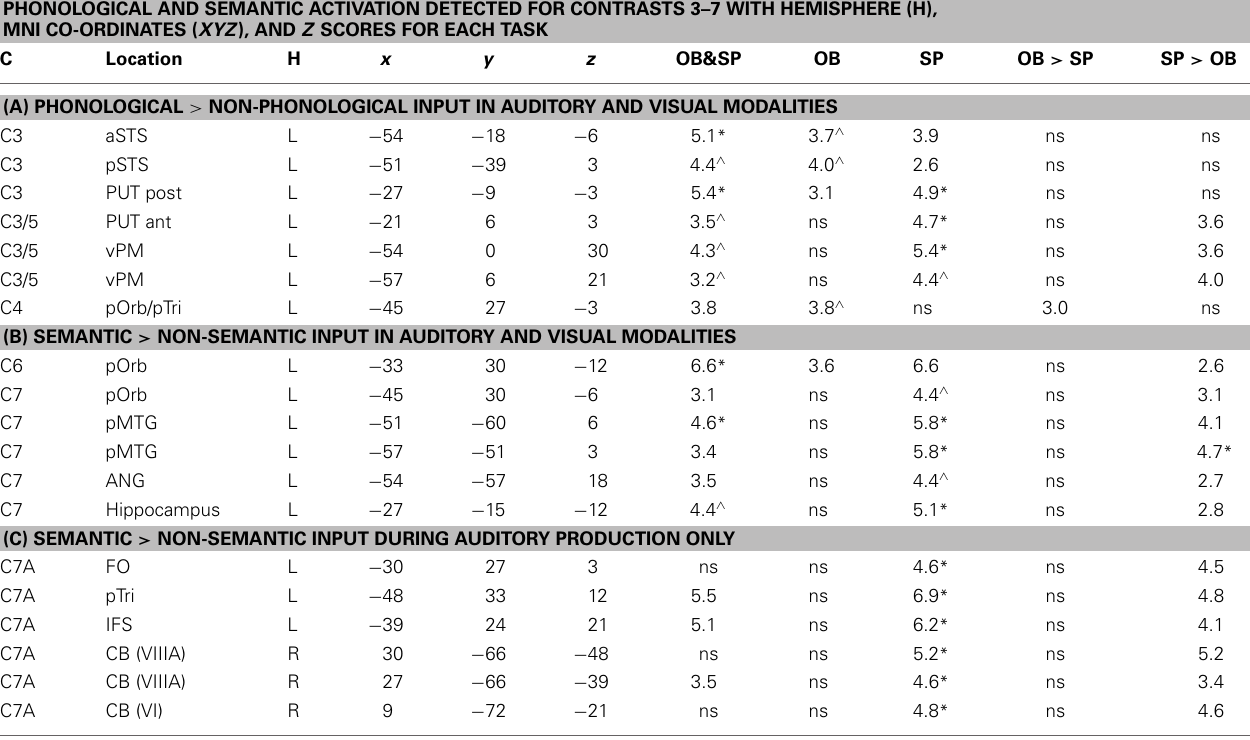
The first column (C) reports the contrast number used in Table 1 . The second column gives the anatomical name of the location of the activation using abbreviations explained in Table 4 . The third column indicates the hemisphere (H), either left (L), or right (R). The fourth column gives the x, y, and z co-ordinates of the peak activation in MNI space. The last five columns give the Z scores for the effect of interest over task contrast OB&SP, OB only, SP only, OB > SP, and SP > OB. Note that the latter two effects indicate the interaction of task with the effect of interest (phonology or semantics). The main effect of task (over semantic and phonological stimuli) is reported Table 6 . Effects that survived family wise error correction for multiple comparisons are marked “ * ” and “ ∧ ” for height and extent, respectively. Effects that were not significant at p < 0.01 uncorrected are marked